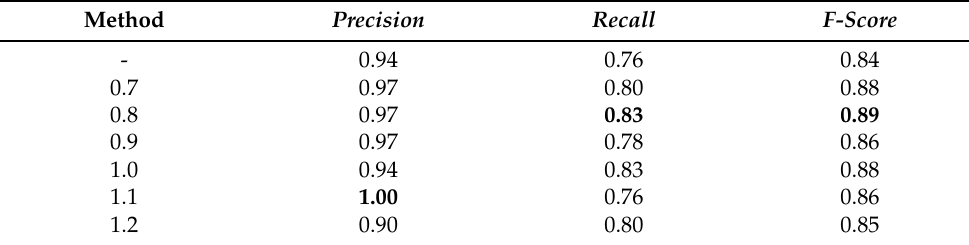
Table 4. The performance of the MTCformer with different p